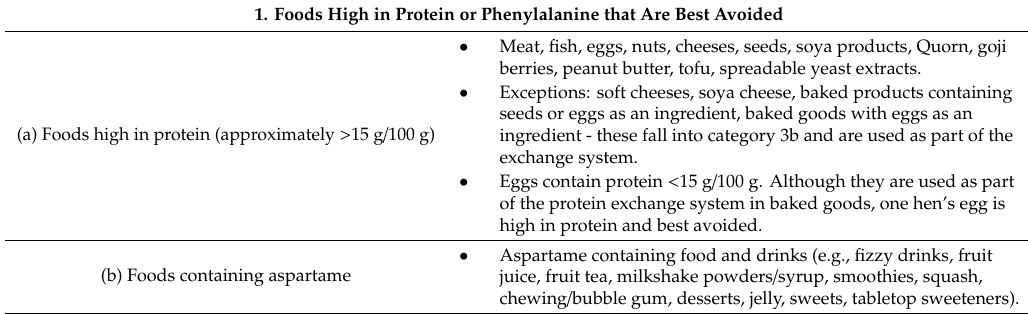
Table 1. Category 1: Foods high in protein or phenylalanine.